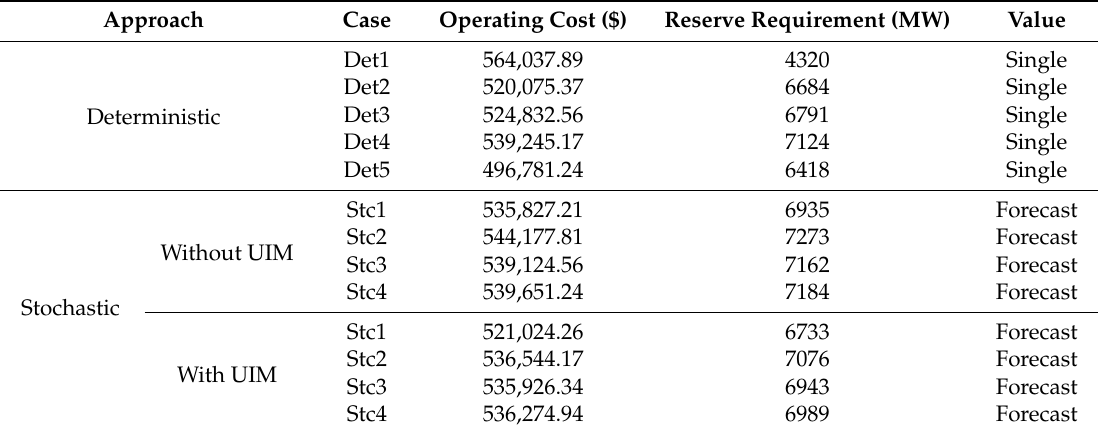
Table 4. Comparison of UC operating costs and reserve